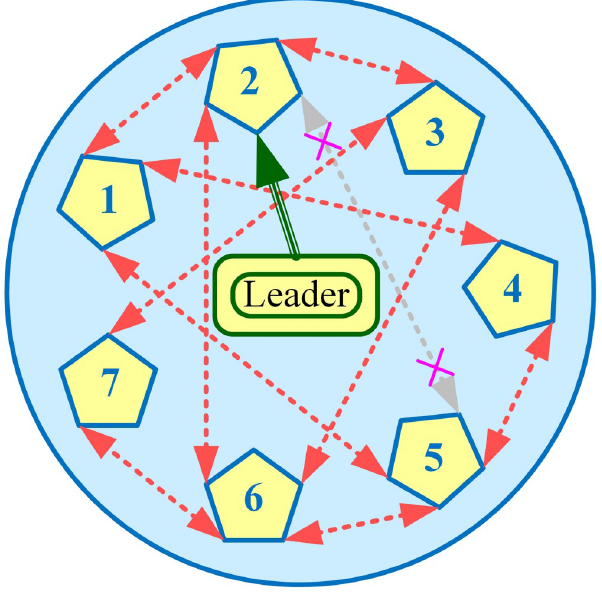
Fig 21. Communication graph when communication link between BESS2 and BESS5